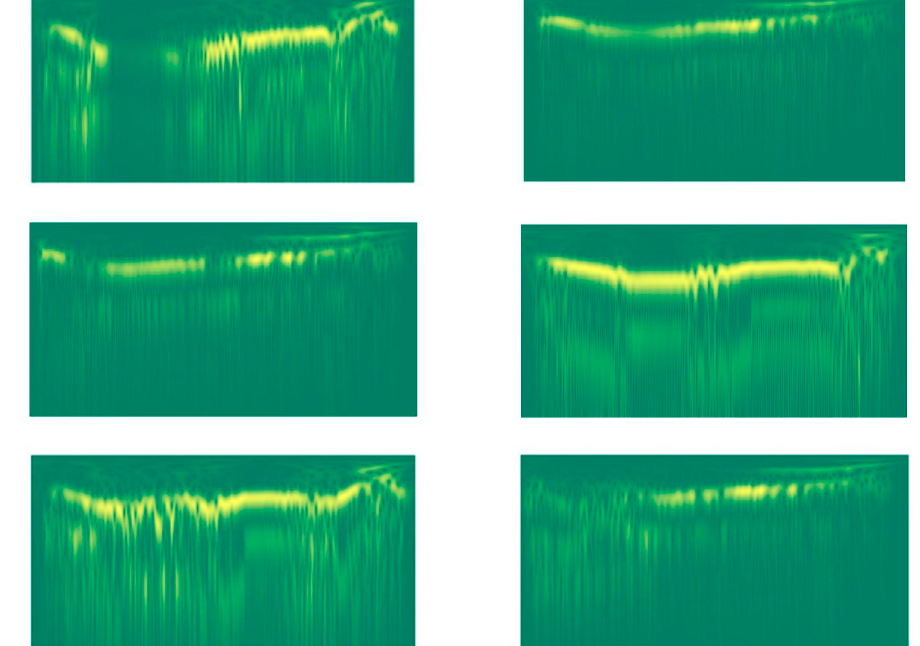
Figure 3. Stockwell images of two different lions (the three images of each column are related to a given lion).